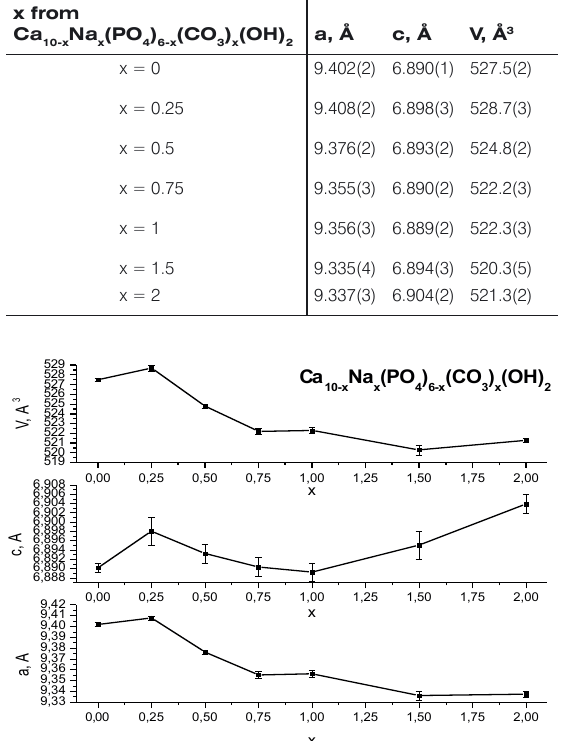
Figure 2. Cell parameters vs . x of CHA.